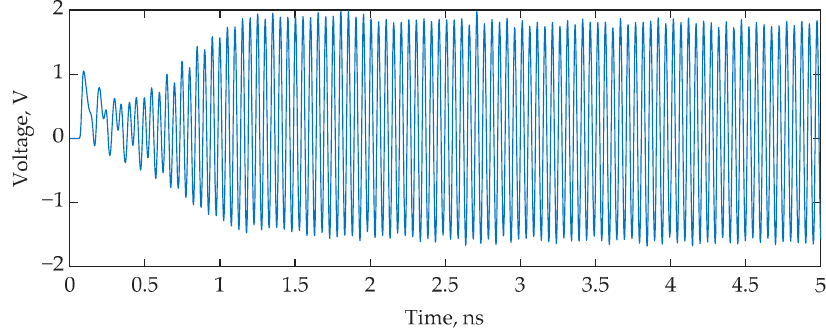
Figure 9. OEO start process for SOI-based MRR interrogation.